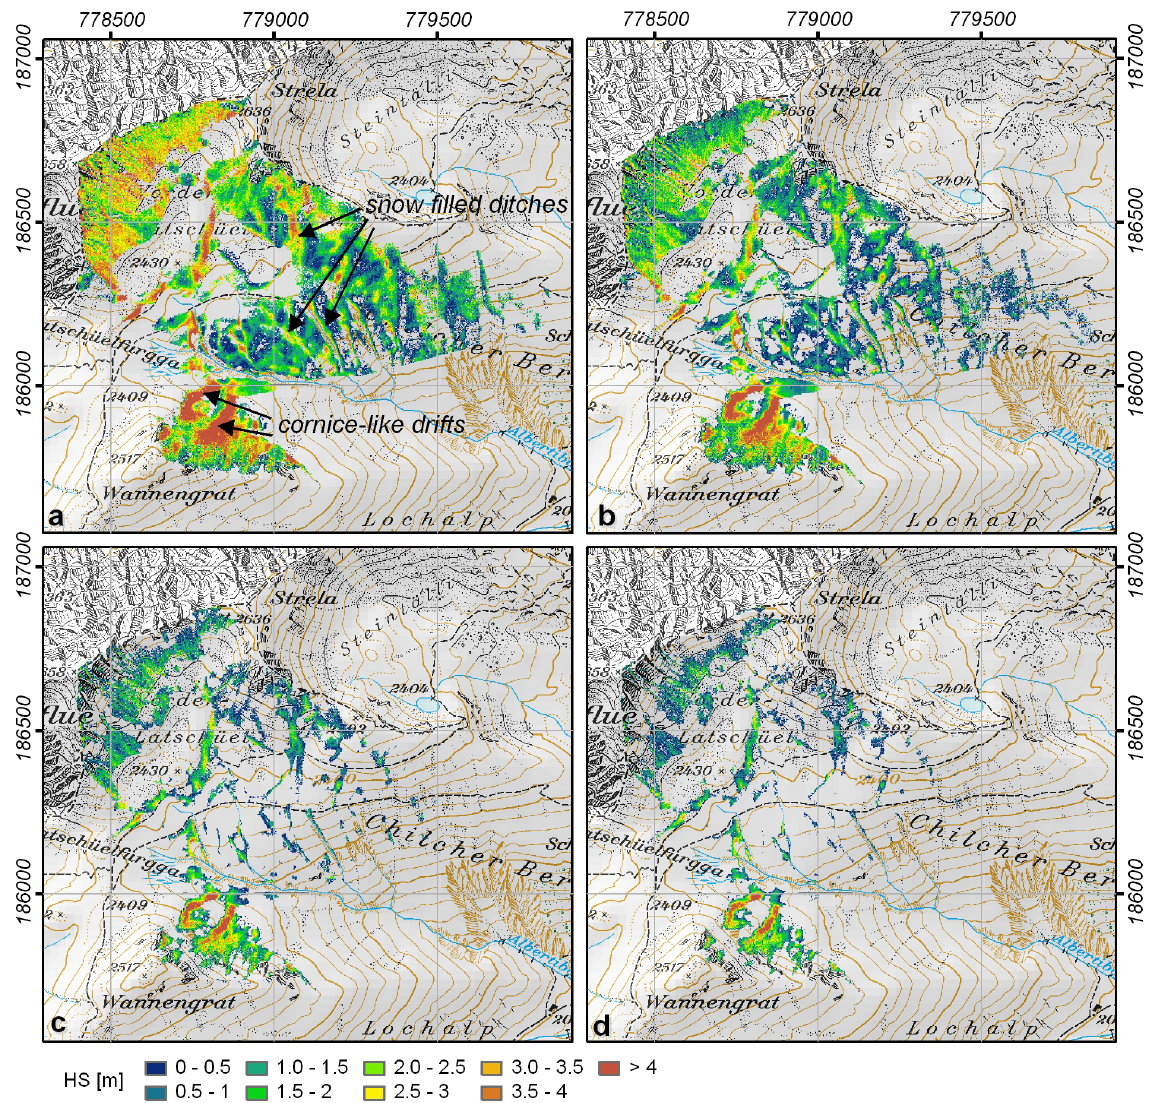
Fig. 3. Snow depth maps for 26 April (a) , 13 May (b) , 2 June (c) and 10 June (d). The black arrows mark examples for snow filled ditches and cornice-like drifts. (base map: Pixelkarte PK25 © 2009 swisstopo